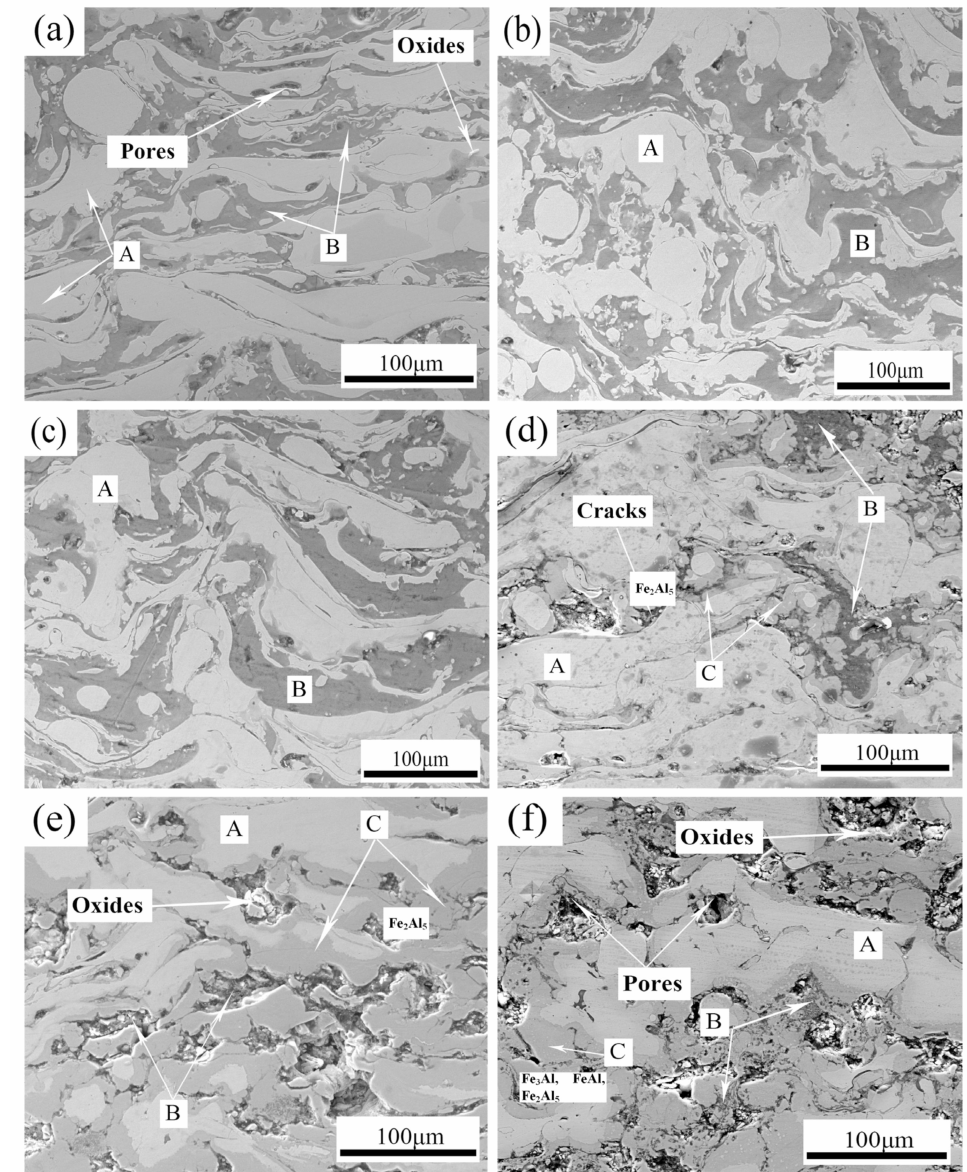
Figure 1. SEM images in back scattered electron mode of the ( a ) as-sprayed coating and coatings annealed at ( b ) 300 ◦ C, ( c ) 400 ◦ C, ( d ) 500 ◦ C, ( e ) 600 ◦ C, ( f ) 700 ◦ C, respectively, composed of FeCrAl splats (region A), Al splats (region B), and intermetallic phase (region